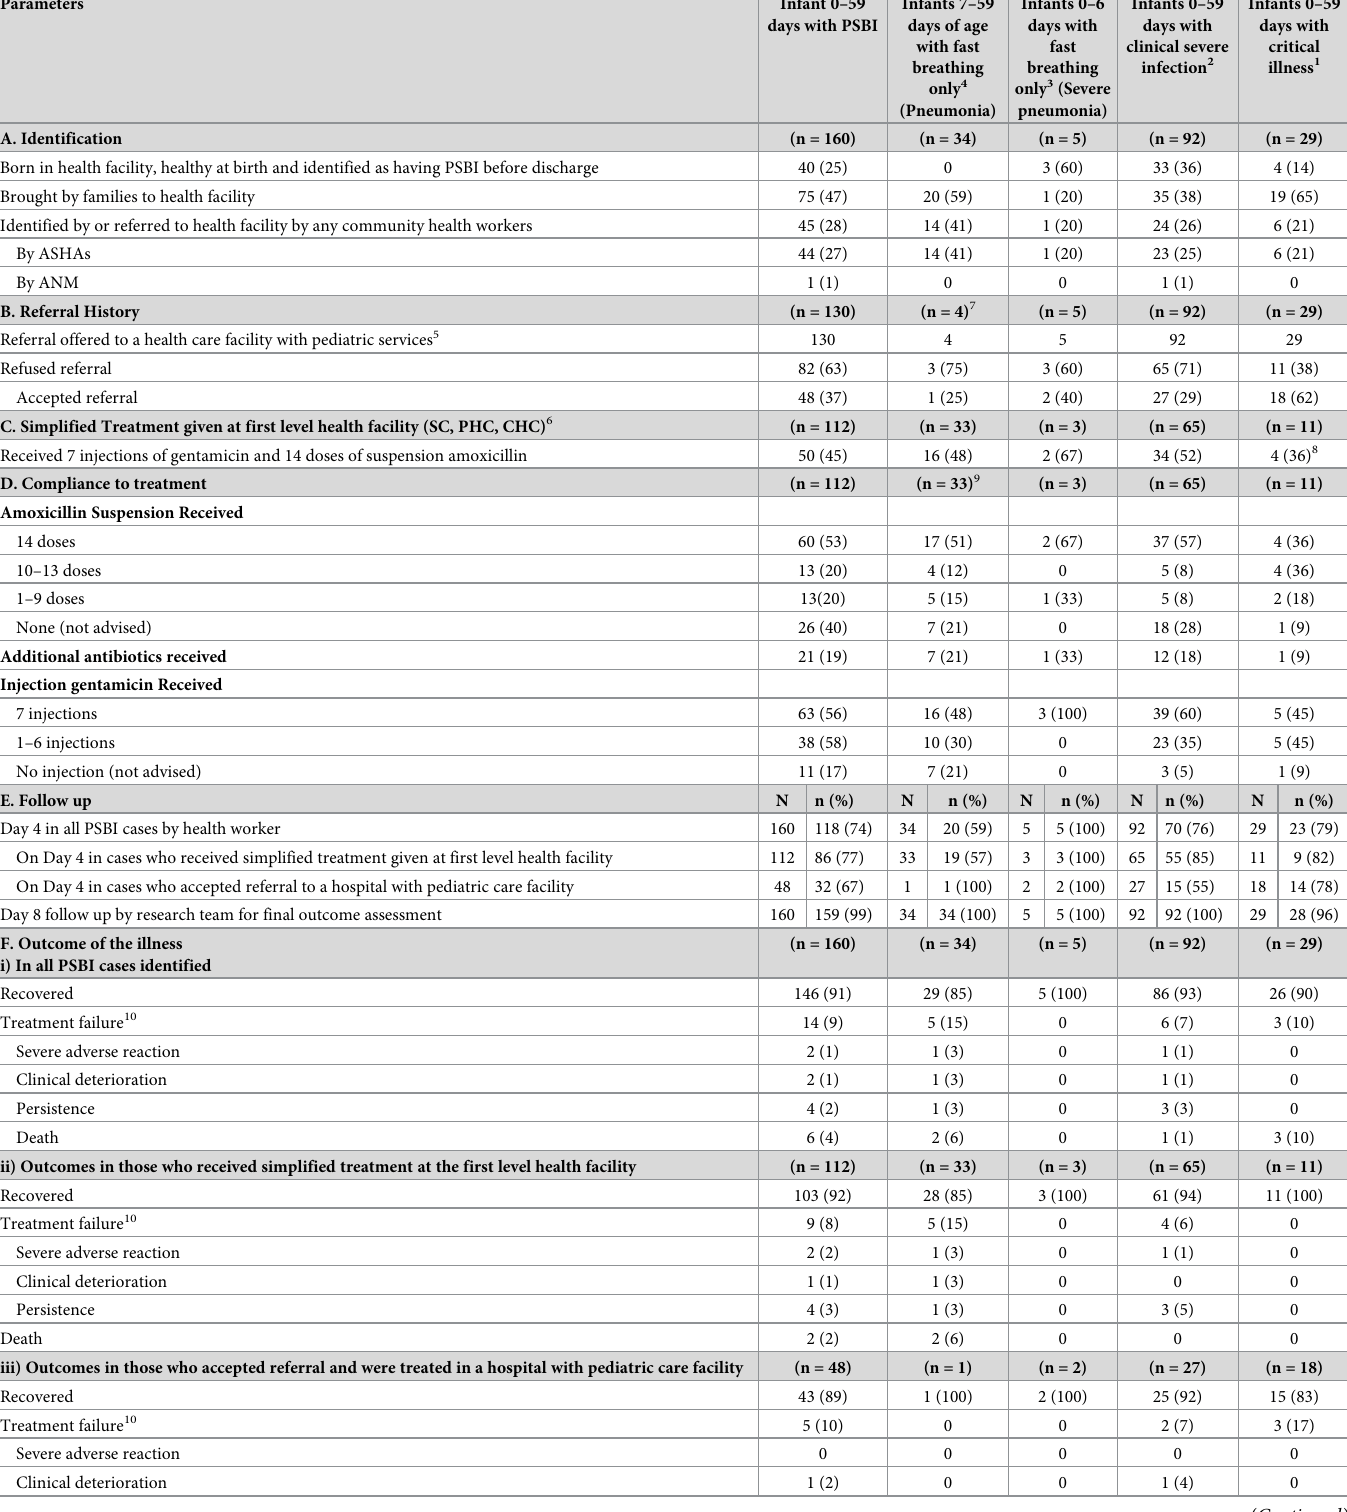
Table 2. Identification, classification, treatment accepted, completion of treatment and treatment outcome for Infants 0–59 days with PSBI.